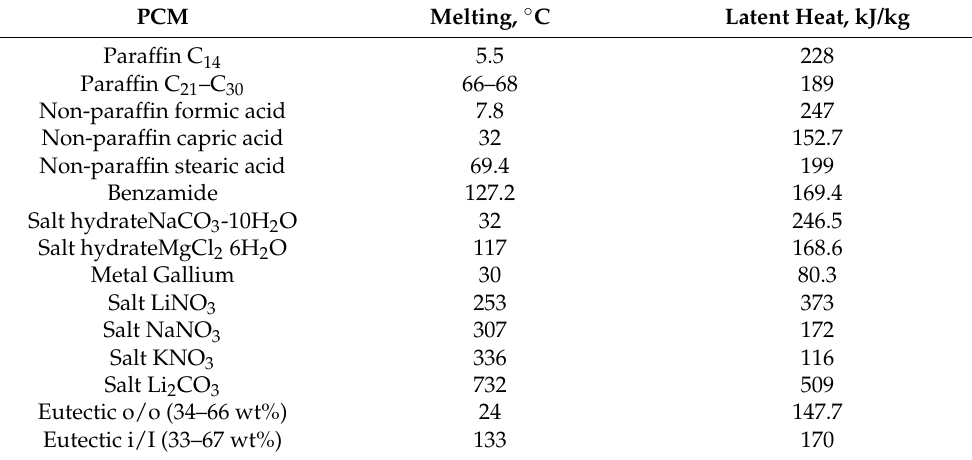
Table 4. Characteristics of PCMS [32].